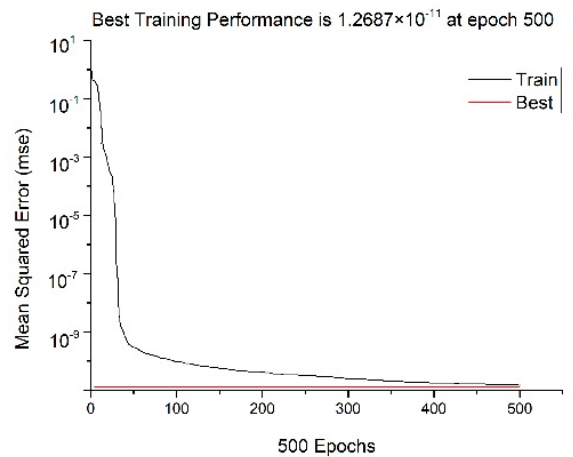
Figure 4. Iterative process of training error.